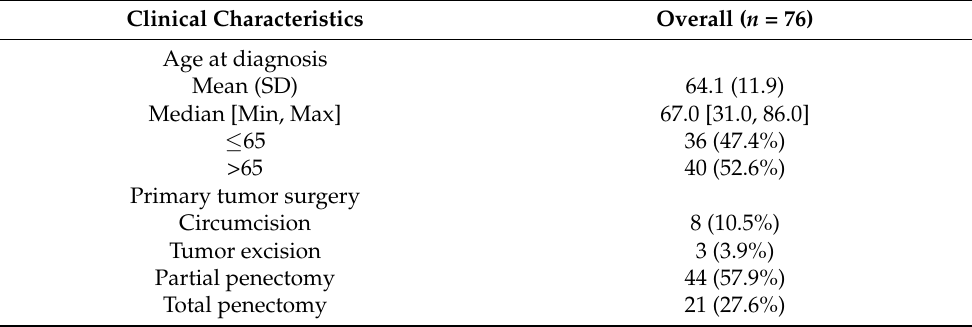
Table 1. Clinical baseline characteristics of the study